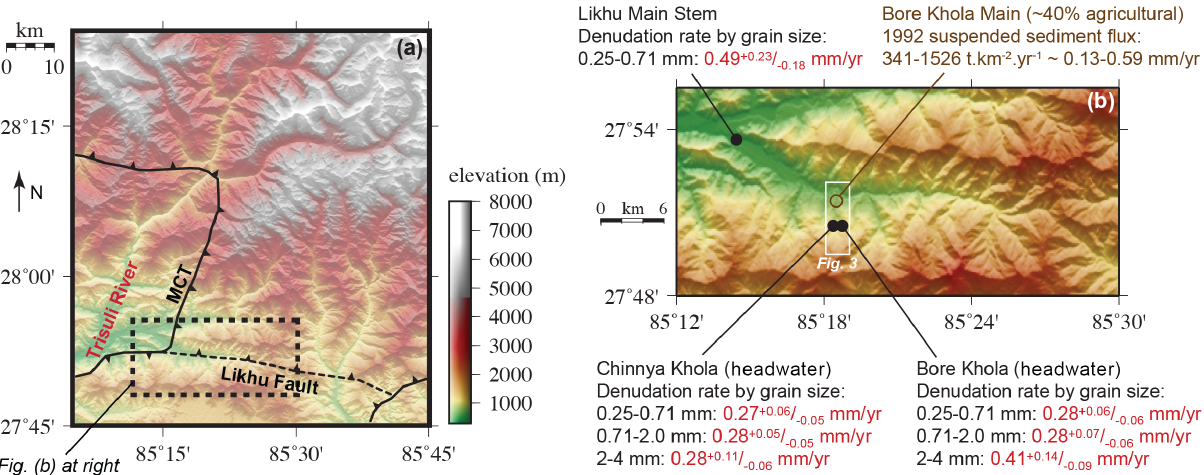
Figure 2. Map of central Nepal north of the Kathmandu Valley (a) and close-up map of the Likhu Khola (b) , showing sampling sites for river sediment and corresponding 10 Be qtz -derived long-term denudation rates (see text). MCT: Main Central Thrust.